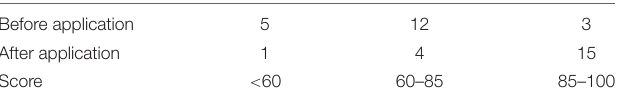
TABLE 3 | Comparison of test scores between the traditional teaching mode and MOOC. Before application 5 12 After application